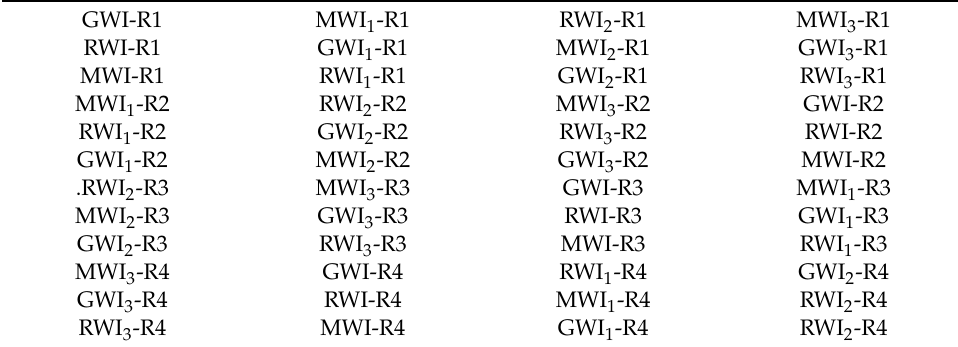
Table 3. Design matrix and randomized configuration of pots representing the corresponding treatments and replications. GWI-R1 MWI 1 -R1 RWI 2 -R1 MWI 3 -R1 RWI-R1 GWI 1